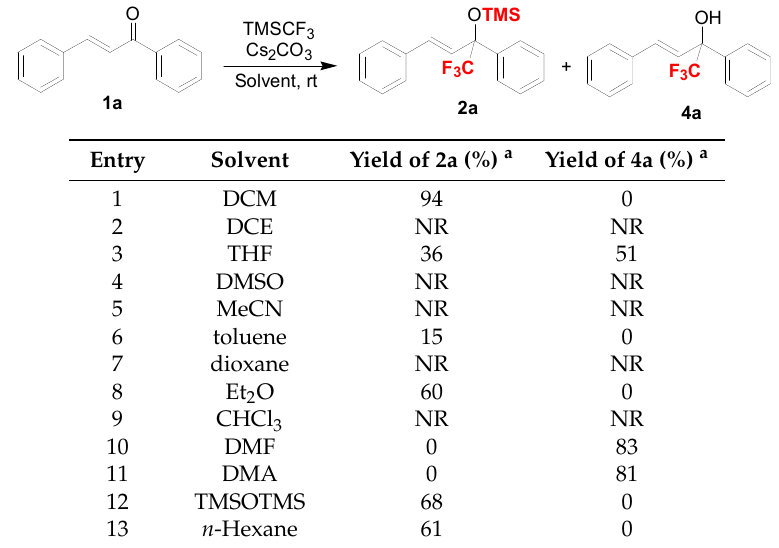
Table 2. The solvent effect on the Cs 2 CO 3 -catalyzed trifluoromethylation of chalcone 1a with TMSCF 3 .